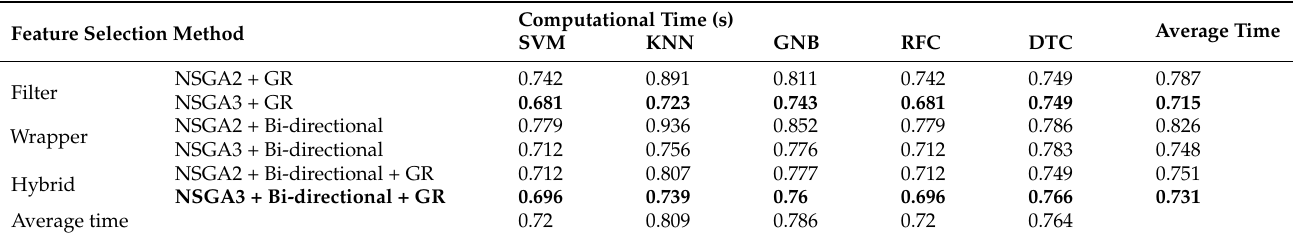
Table 3. Computational time for the feature selection algorithms.